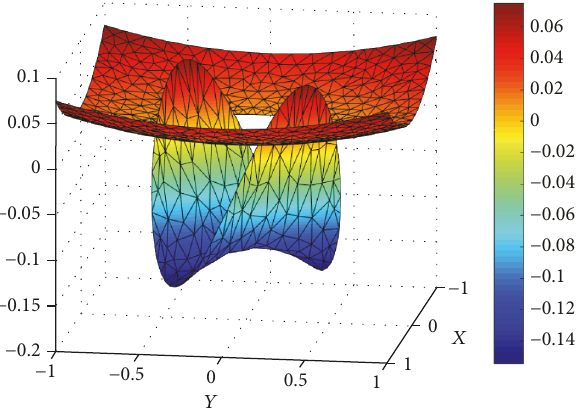
Figure 3: Numerical solution of Example 2.